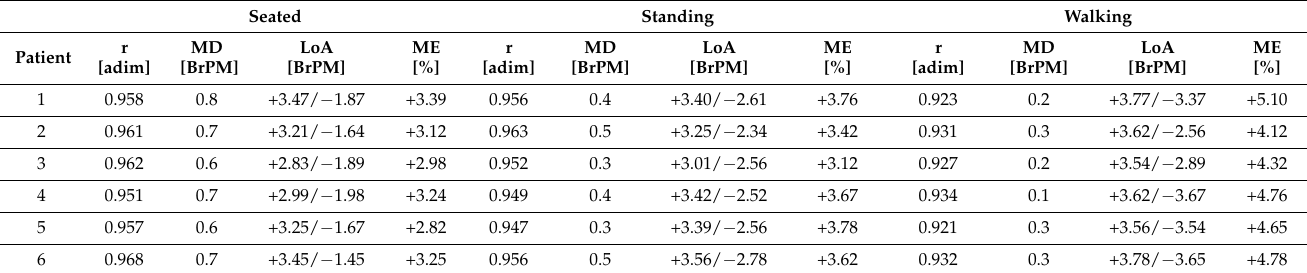
Table 4. Summary table reporting the performance of the chest band in measuring RR for different conditions (seated, standing,